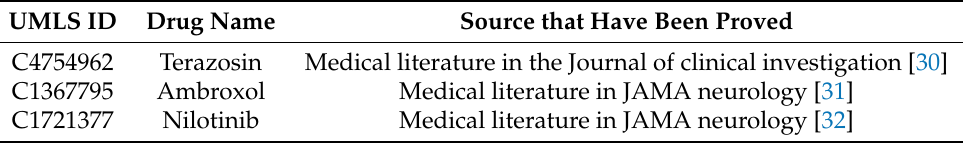
Table 4. Results of drug repurposing by classifier for Parkinson’s